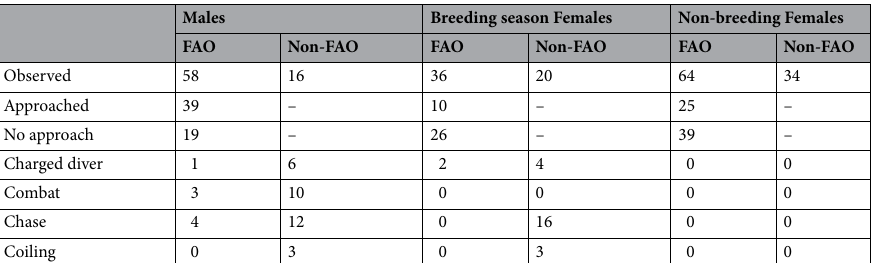
Table 1. Sample sizes of Focal Animal Observations (FAO) and Non-Focal Animal Observations (Non- FAO) of Olive sea snakes ( Aipysurus laevis ). Male snakes were rarely observed outside the breeding season (May–August). In the Table above, “non-breeding females” are those observed outside of the breeding season, whereas “breeding season females” are those observed during the breeding